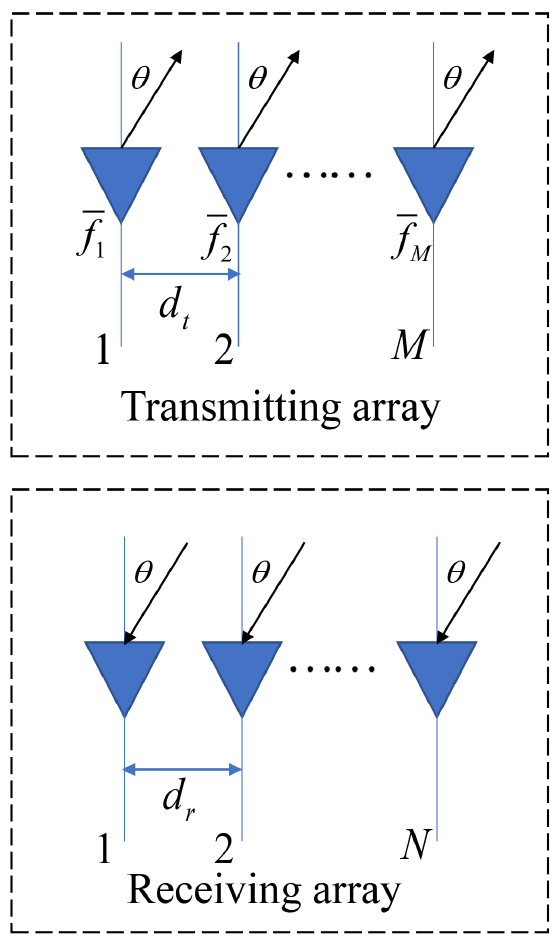
Figure 1. Monostatic FDA-MIMO